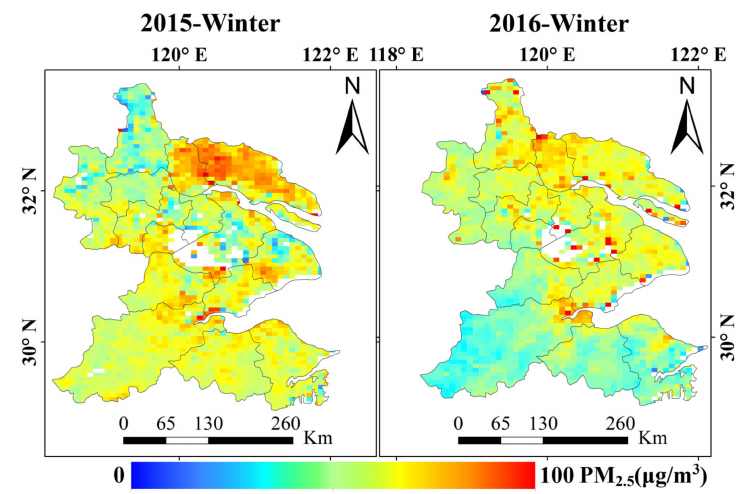
Figure 8. Spatiotemporal distributions of PM 2.5 concentrations in the Yangtze River Delta